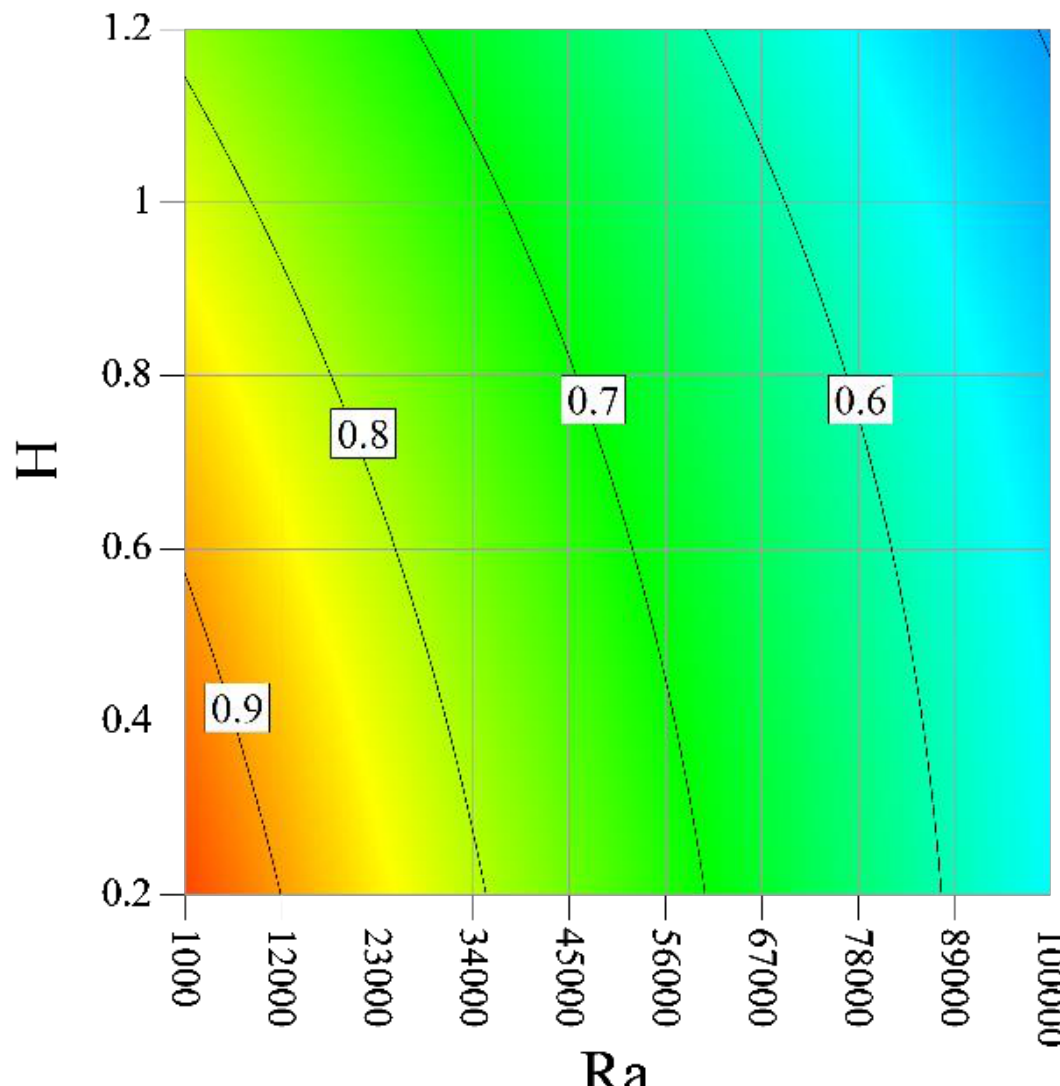
Figure A14. EGN for different Ra and various blade lengths when W = 0.5 and Ha = 30, and the volume fraction is 0.3%. Equation (16) is a correlation to express the total EGN in terms of the Ra, the Ha, and the blade length and